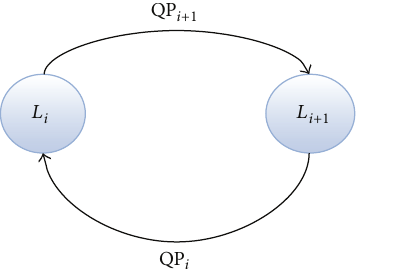
Figure 4: State diagram of the Gilbert Elliot model used for SVC level.